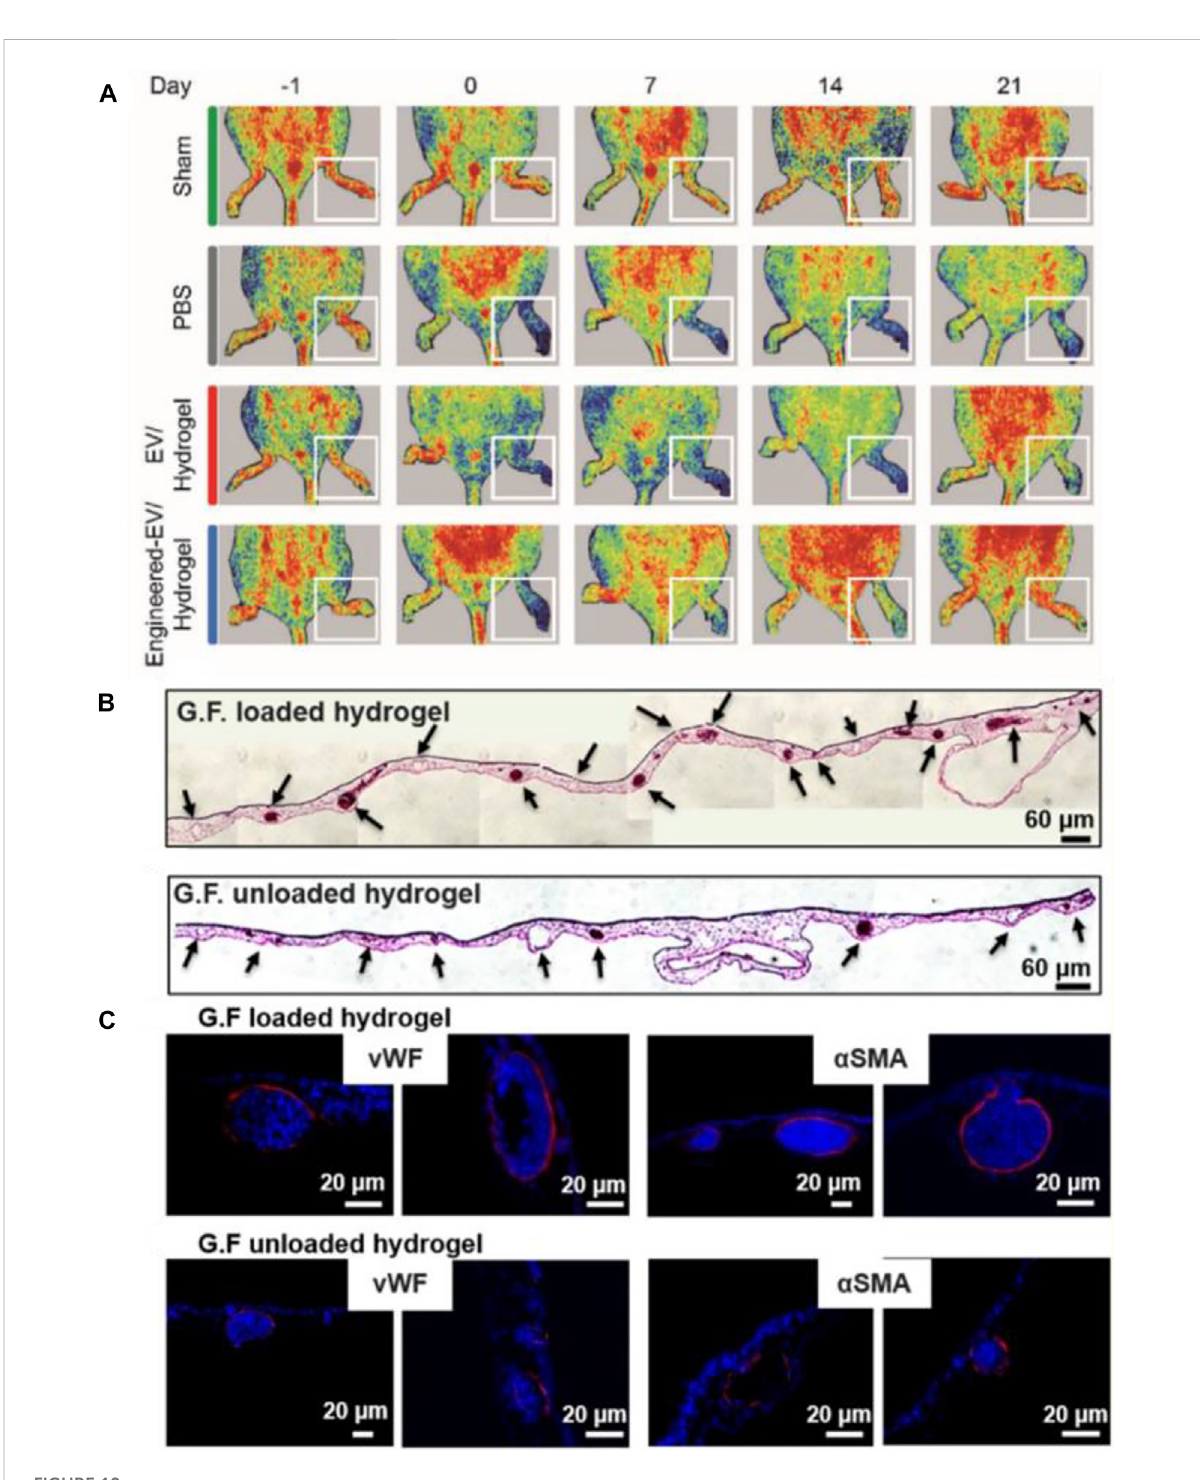
FIGURE 10 Schematic diagrams of hydrogels loaded with growth factors or stem cells to treat LEAD. (A) LDPI images of ischemic hind limbs in a mouse model showed that engineered-EV/hydrogel signi fi cantly improved blood perfusion and preserved the ischemic limb. (B) Representative images of H&E staining showed that the GF-loaded hydrogel could promote tube formation. Scale bar = 60 µm. (C) Representative images of immunohistochemistry staining showed that the GF-loaded hydrogel could improve angiogenesis. Scale bar = 20 µm. (A) is reprinted with permission from ref. (Xing et al., 2021b). (B,C) are reprinted with permission from ref. (Huang et al.,